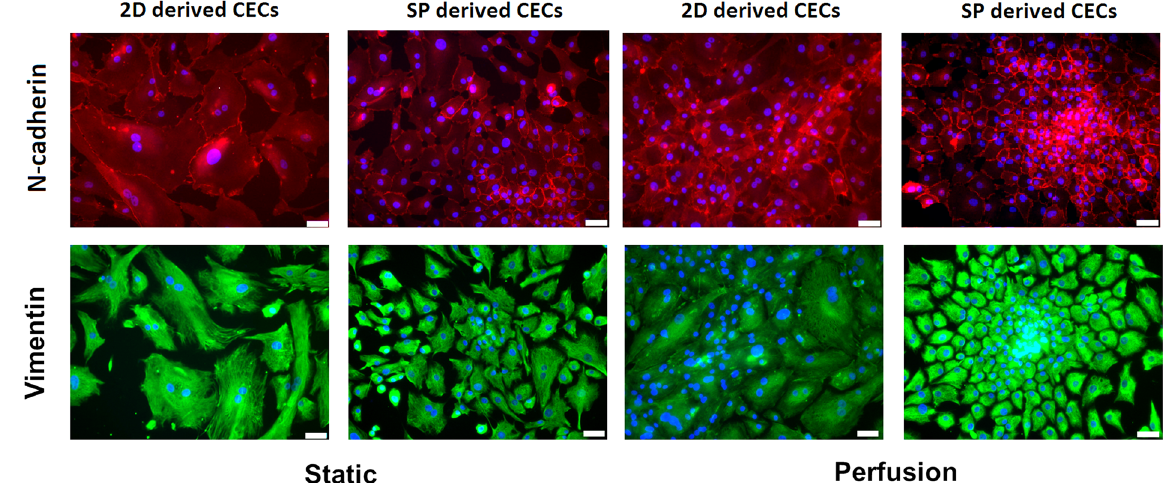
Figure 5. Phenotypic expression of CECs in the static and perfusion systems. Immunofluorescence staining for N-cadherin and vimentin in 2D- and SP-derived CECs in the static and perfusion systems. Cell nuclei were counterstained with DAPI. Scale bar: 50 µ m.